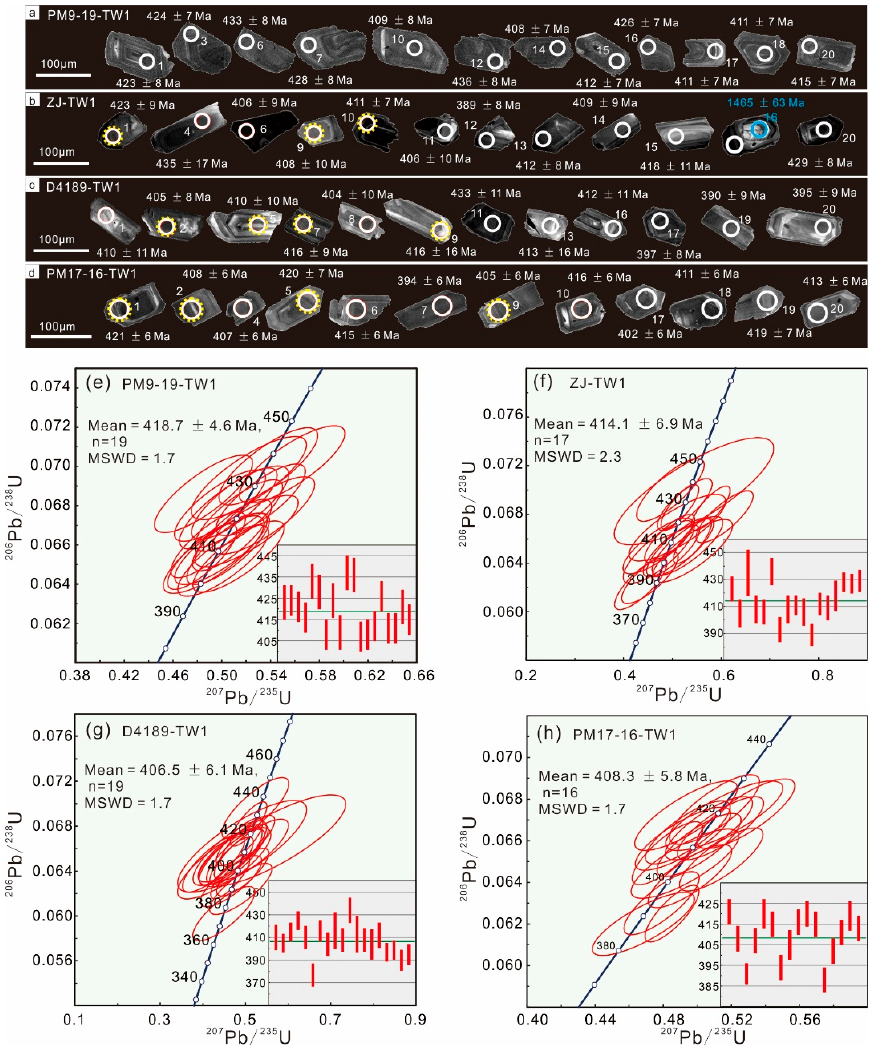
Figure 4. Photomicrographs ( a – d ) of representative zircon grains analyzed for U-Pb ages and Hf isotopes, and Zircon U-Pb concordant diagrams ( e – h ) for the volcanic rocks in the Haerdaban area. The white or blue circles indicate the analytical spots for U-Pb isotopes and yellow circles denote the analytical spots for Hf isotopes. ( a , e ): the sample PM9-19-TW1; ( b , f ): the sample ZJ-TW1; ( c , g ): the sample D4189-TW1( d , f ): the sample PM17-16-TW1